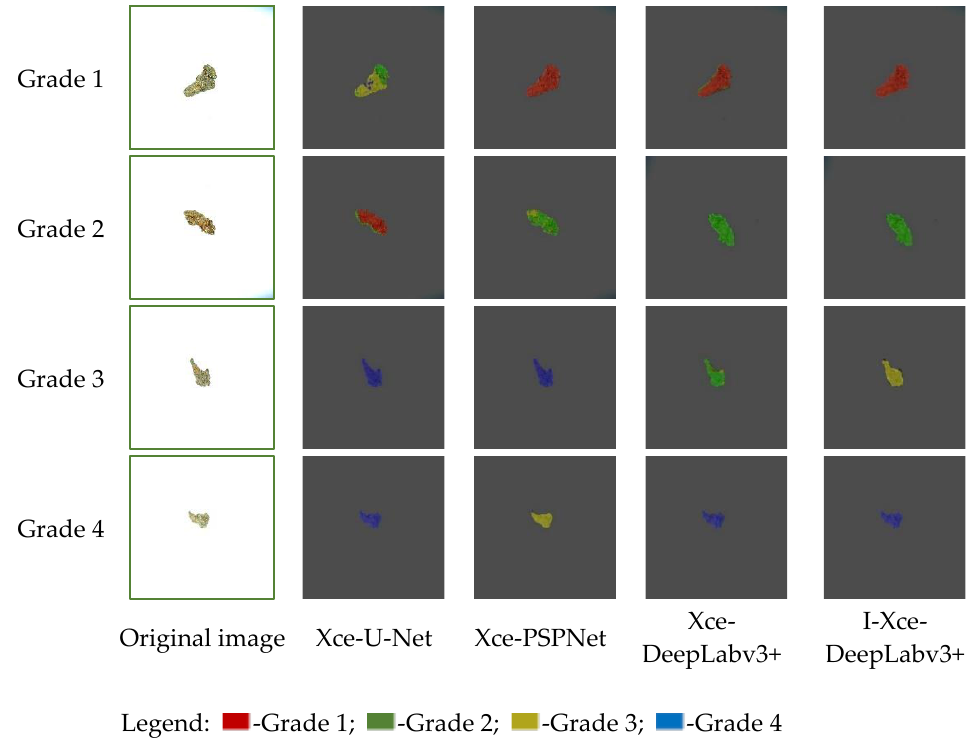
Table 2. Performance of different segmentation networks.